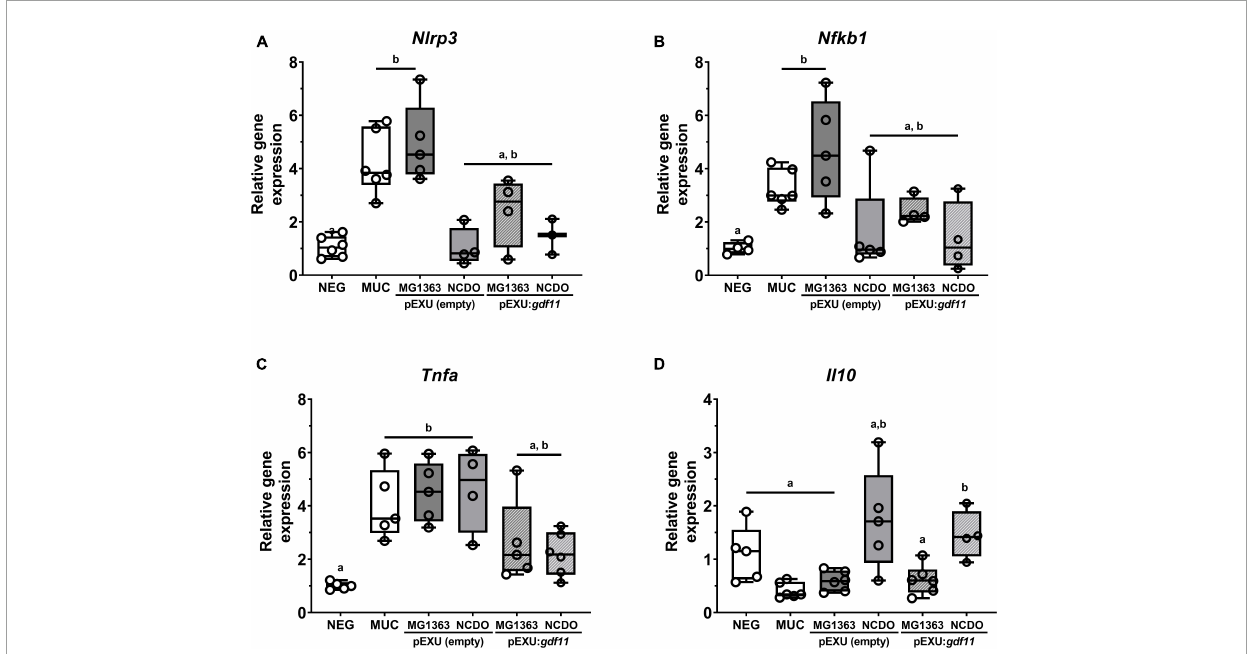
FIGURE5 Immunomodulatory effect of recombinant L. lactis (pExu: gdf11 ) on inflammatory markers of mucositis ( n = 3–5). (A) Nlrp3, (B) Nfkb1 (p105), (C) Tnf, and (D) Il10 following 2 (cid:49)(cid:49) Ct method of analysis. Different letters (a and b) indicate a significant difference ( p < 0.05) among groups by one-way ANOVA and Tukey’s multiple comparison